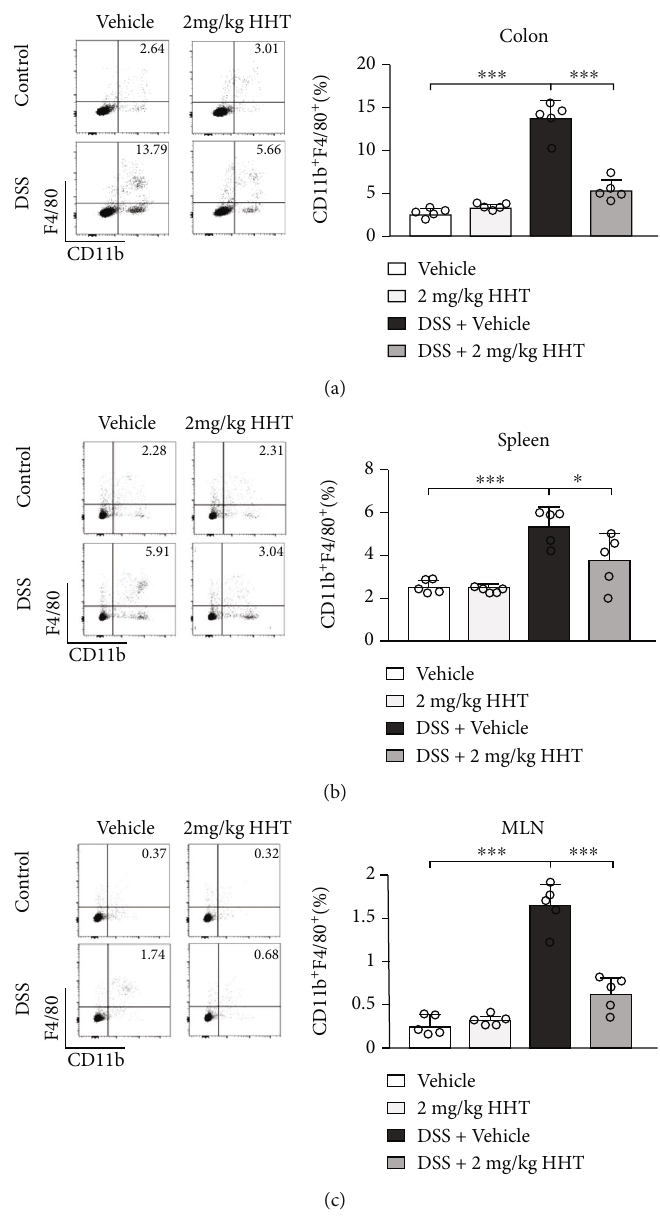
Figure 3: HHT inhibits the recruitment of macrophages induced by DSS in the colon. Mice were treated with 3% DSS along with vehicle or 2mg/kg HHT for seven days, and the colon tissues (a), spleens (b), and mesenteric lymph nodes (MLN) (c) were harvested for FACS analysis. The proportion of macrophages (CD11b + F4/80 + cells) was determined. Five mice per group. Error bar represents mean ± SD . ∗ p < 0 : 05 ; ∗∗∗ p < 0 : 001